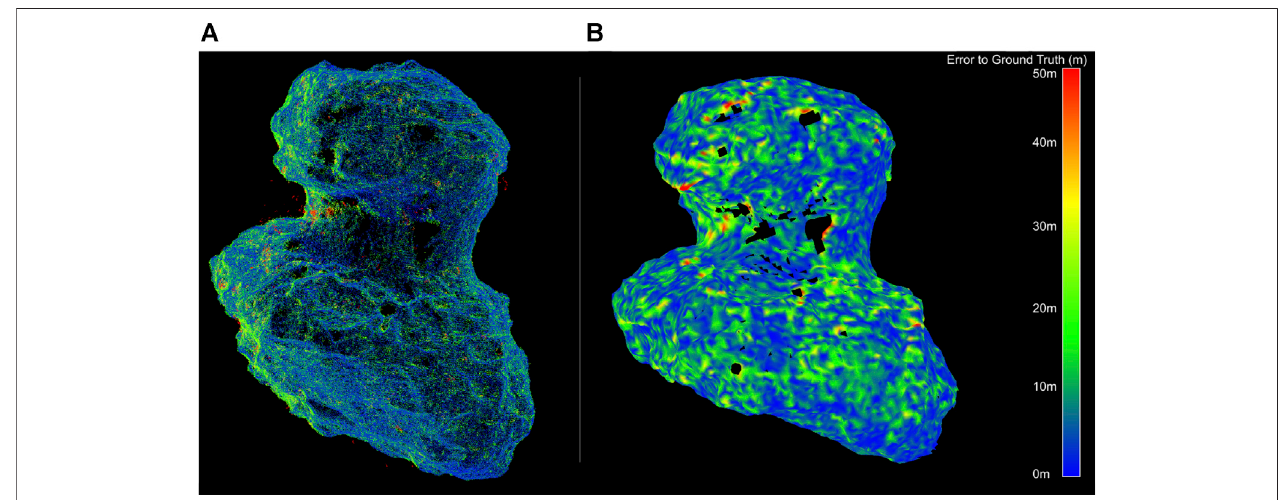
FIGURE 5 | Example performance of dense 3D mapping algorithms on comet 67P at a body-image span of 1000 pixels (at a distance of 50 km for a 4.3 km body diameter) at a delta rotation of 0.25 ° per frame (i.e., a 30-s imaging interval). (A) Down-sampled accumulation ofpoint clouds from depth reconstruction using REMODE (Pizzoli et al., 2014). (B) Filtering of the point clouds into a signed-distance fi eld from which a mesh is extracted (using Voxblox (Oleynikova et al., 2017)).